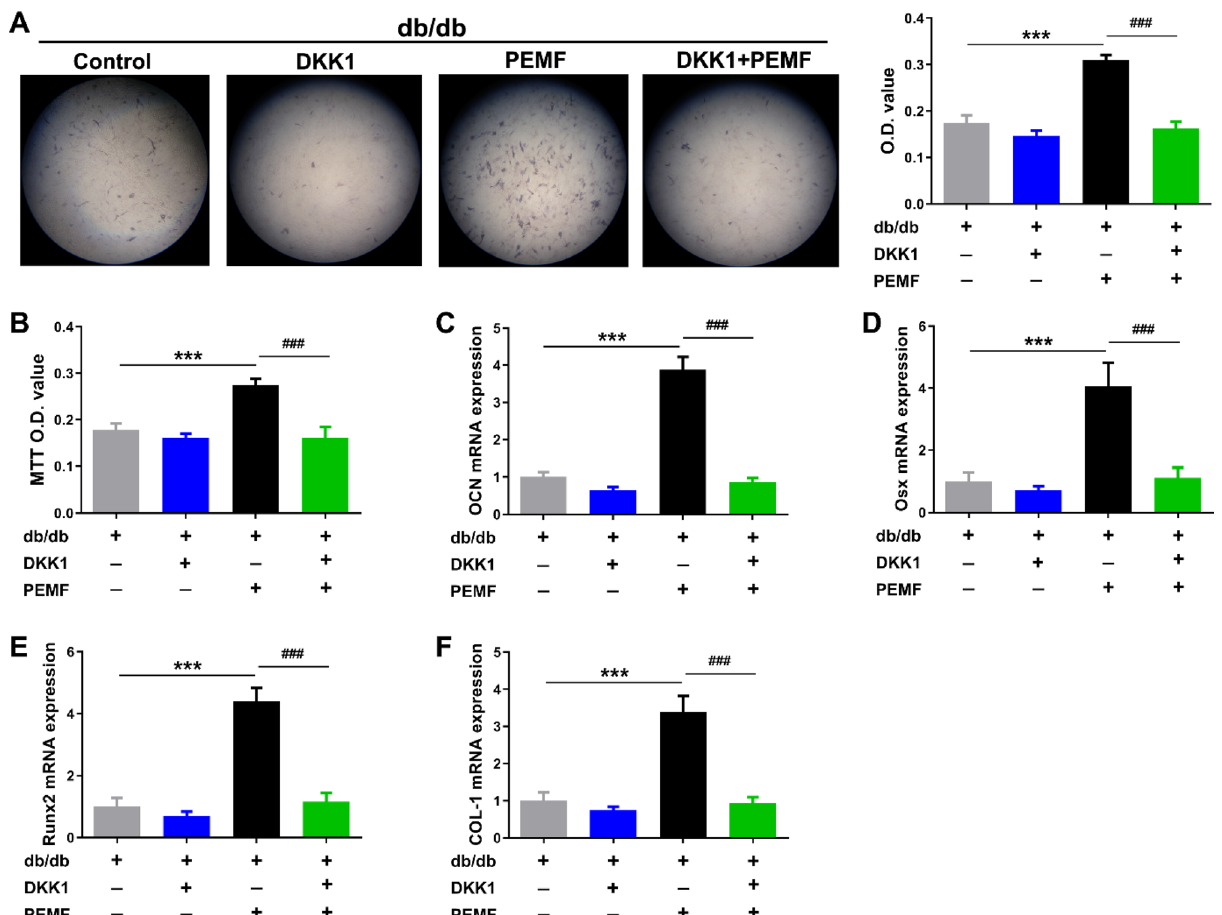
Figure 5. Wnt antagonist DKK1 blunts pulsed electromagnetic fields (PEMF)-induced acceleration of cellular differentiation and proliferation of in vitro primary osteoblasts isolated from mandibular bone of db/db mice. ( A ) In vitro osteoblast differentiation assays based on alkaline phosphatase staining. ( B ) MTT assays for in vitro primary osteoblast proliferation. ( C–F ) Analysis of in vitro osteoblastic differentiation-related gene expression, including osteocalcin (OCN), Runx2, Osx and COL-1. Data are represented as mean ± SEM ( n = 7–10/group). *** P < 0.001 vs. the db/db mice group; ### P < 0.001 vs. the db/db mice with PEMF exposure group by one way analysis of variance (ANOVA) followed by Bonferroni’s multiple